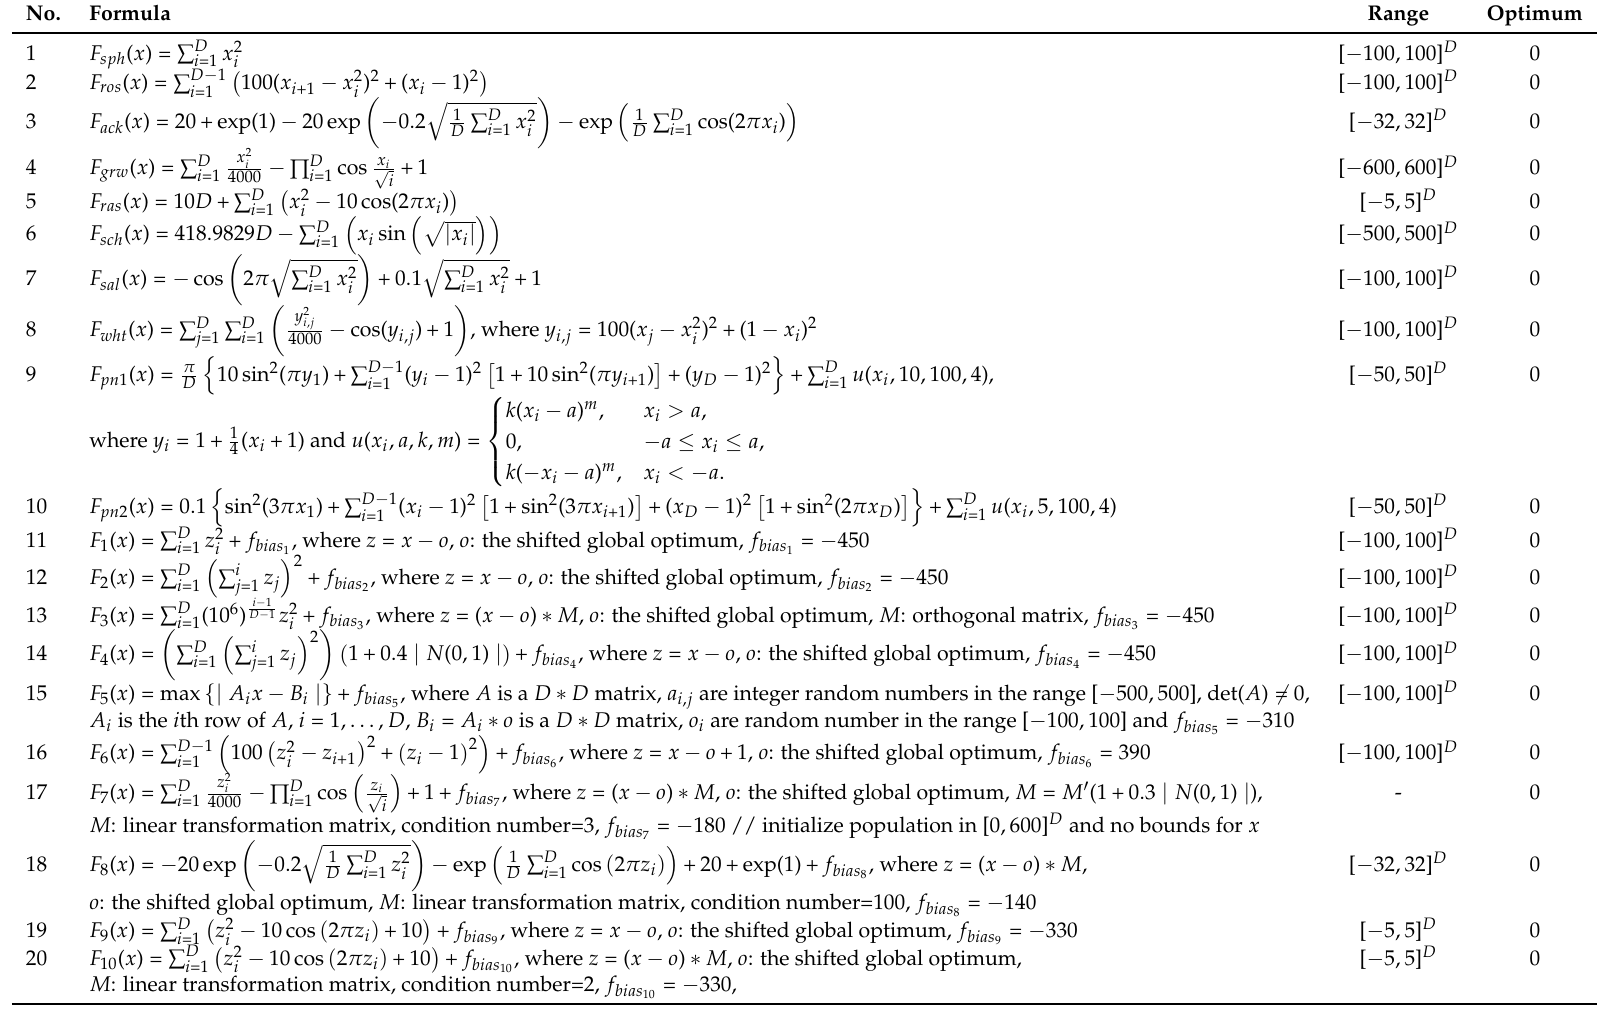
Table A1. Description of the benchmark functions at dimension D used in